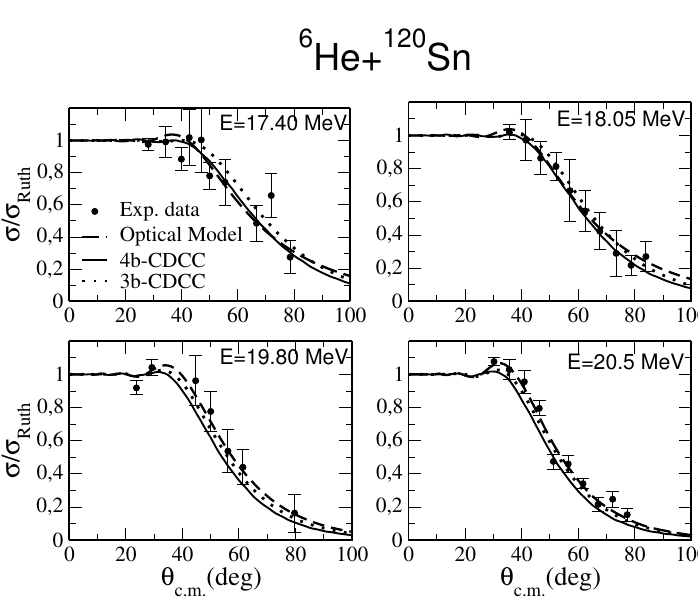
Figure 1. 6 He + 120 Sn elastic scattering angular distributions from ref.